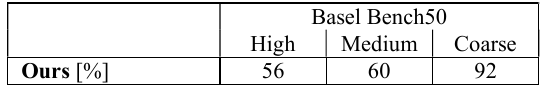
Table 3. Results on Own Data